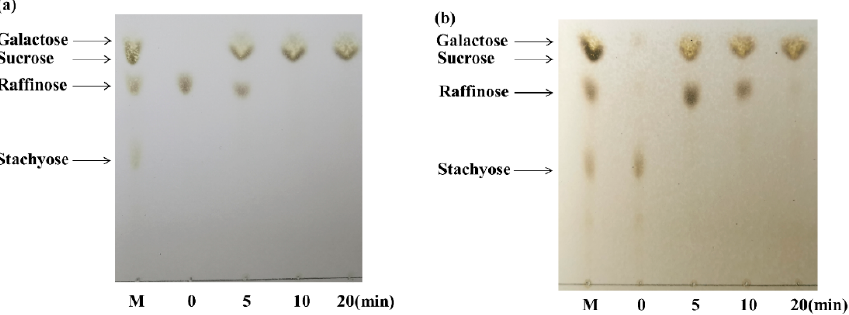
Figure 6. TLC analysis of the hydrolysis products of raffinose ( a ) and stachyose ( b ) by galV. Lane M, a mixture of galactose, sucrose, raffinose, and stachyose.